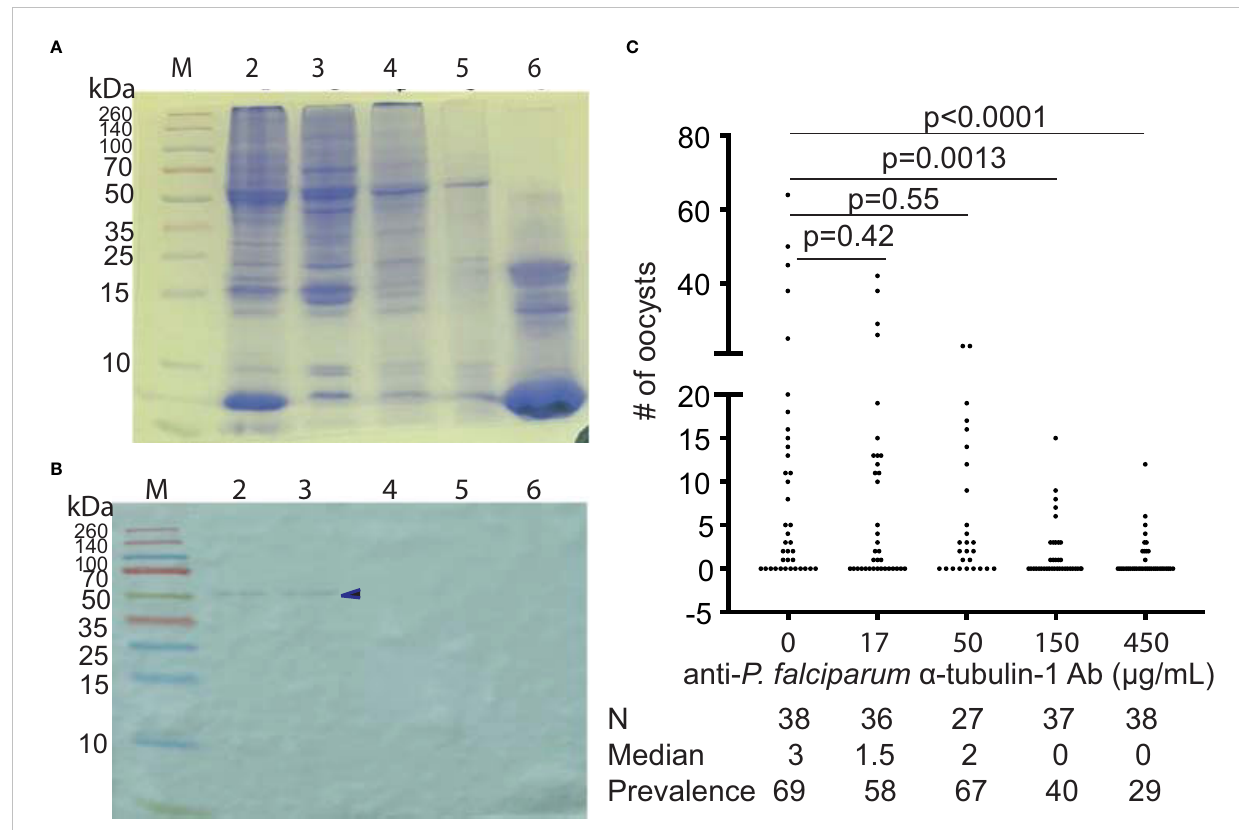
FIGURE 3 Puri fi ed rabbit pAb recognizes P. falciparum a -tubulin-1 and inhibits the P. falciparum transmission to An. gambiae . (A) Proteins in cell lysates were separated by SDS-PAGE and (B) analyzed by immunoblotting showing the puri fi ed rabbit pAb recognize P. falciparum a -tubulin-1. Lanes, M: protein ladder; 2: P. falciparum lysate; 3: a -tubulin-1 expressed Hi5 lysate; 4: Hi5 lysate; 5: HEK 293 cell lysate. 6: Whole blood lysate. (C) The number of oocysts (infection intensity) in individual mosquitoes and prevalence in the presence of puri fi ed rabbit anti- P. falciparum a -tubulin-1 Ab at different concentrations (0,17, 50, 150, and 450 m g/ml) by SMFA. N, number of mosquitoes. P values were calculated by Mann-Whitney